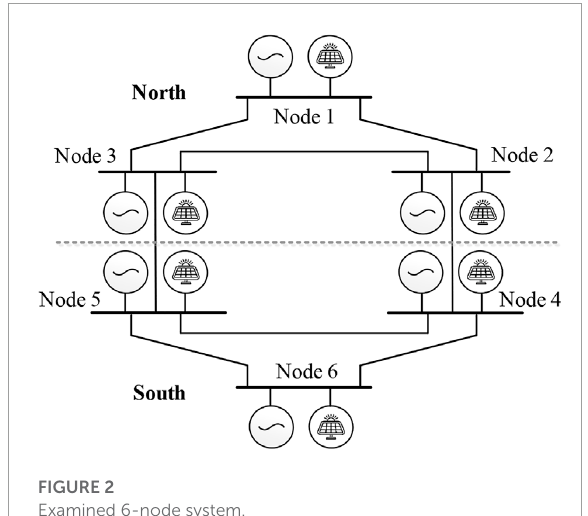
FIGURE 2 Examined 6-node